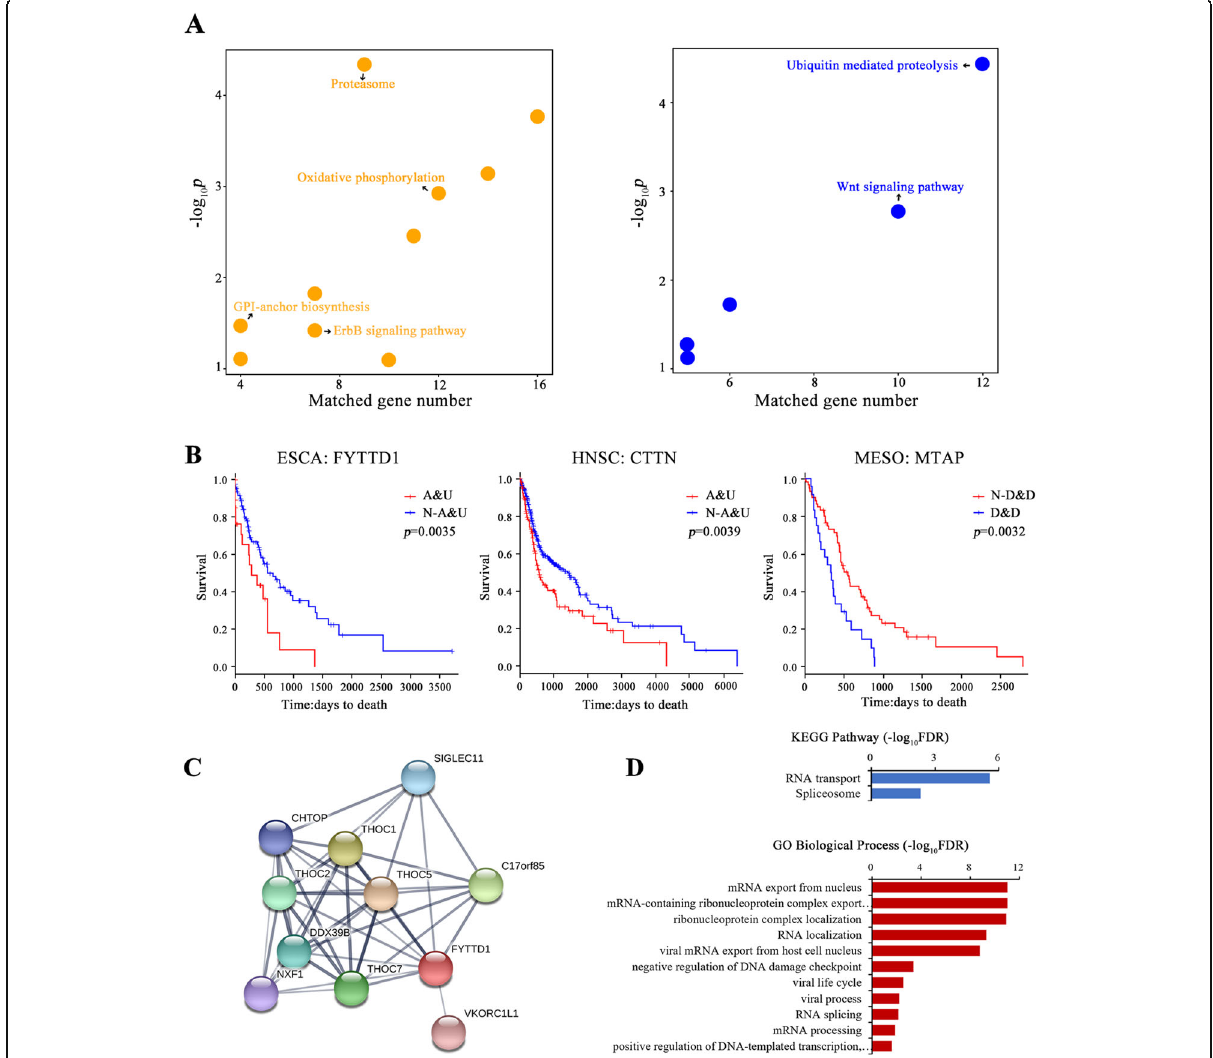
overall survival (OS) based on variation tendency of FYTTD1 in ESCA, CTTN in HNSC and MTAP in MESO. A&U represents samples with copy number amplification and gene expression upregulation, N-A&U represents samples without copy number amplification and gene expression upregulation; D&D represents samples with copy number deletion and gene expression downregulation, N-D&D represents samples without copy number deletion and gene expression downregulation. c. PPI network of interactive proteins with FYTTD1 by using STRING platform. d. Functional enrichments of the PPI network including GO biological process and KEGG